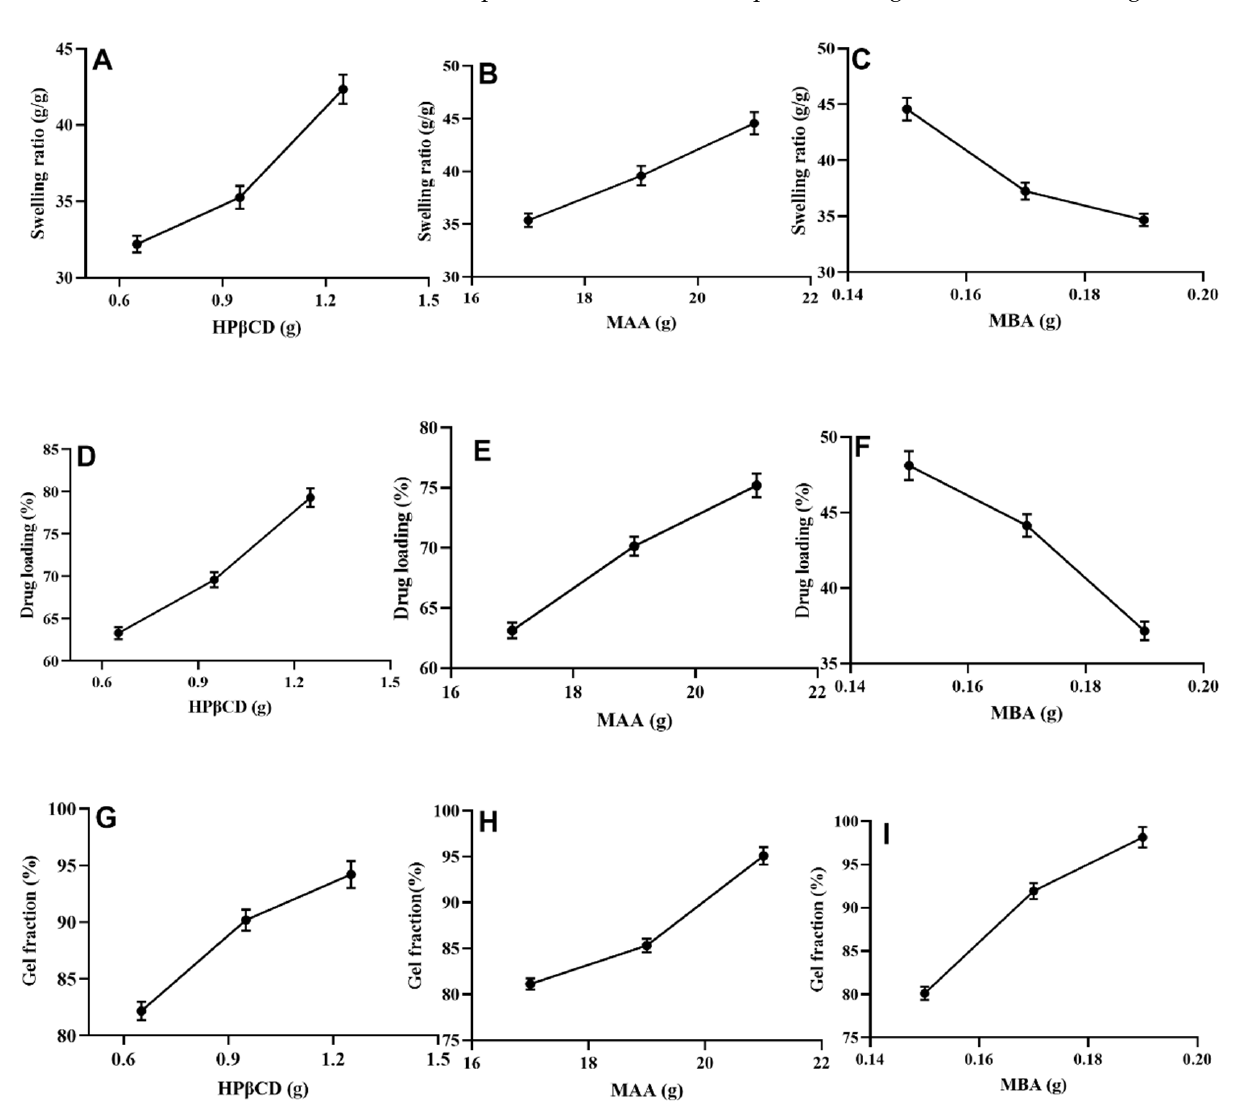
Figure 4. Effect of HP β CD on swelling ratio ( A ), % drug loading ( D ), and % gel fraction ( G ), effect of MAA on swelling ratio ( B ), % drug loading ( E ), % gel fraction ( H ), effect of MBA on swelling ratio ( C ), % drug loading ( F ) and % gel fraction ( I ).